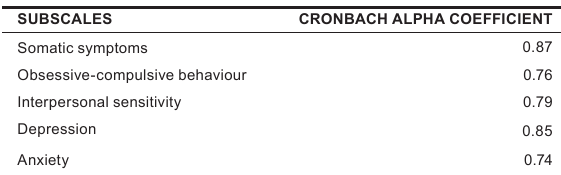
Internal-consistency reliabilities of the subscales of the Hopkins Symptom